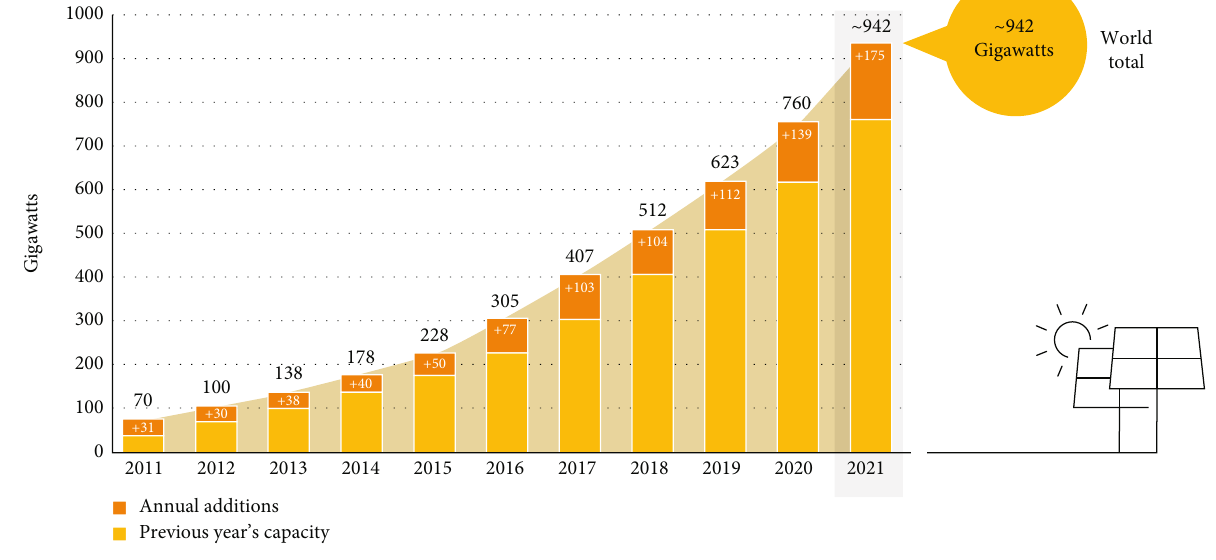
Figure 1: PV global capacity from 2011 to 2021